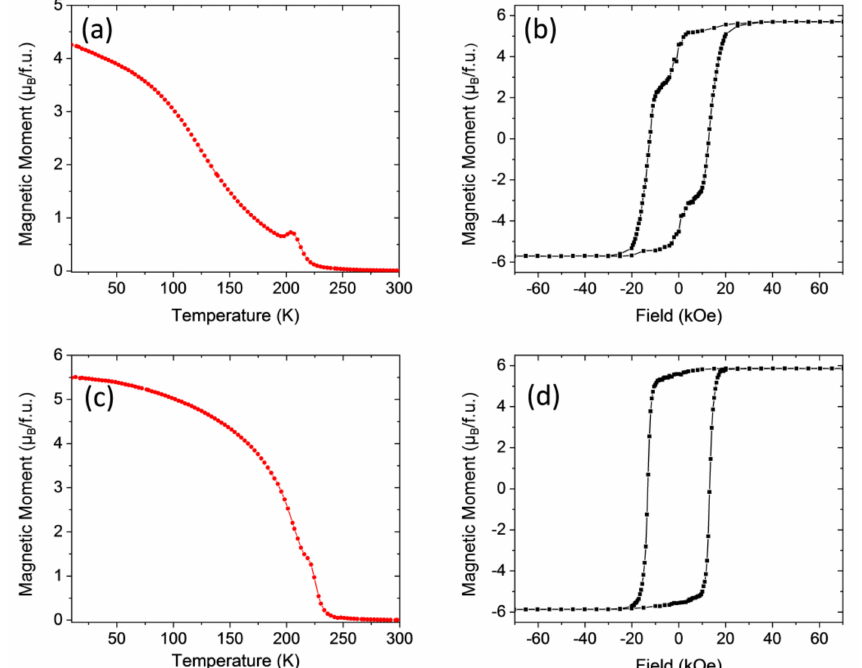
Figure 3. ( a ) Magnetization vs. temperature of LCMO / STO–1 film measured after field cooling with a magnetic field of 1 kOe applied parallel to (001)-STO (out of plane). ( b ) M–H loop of the same sample recorded at 10 K, magnetic field H applied out of plane. ( c ) Temperature dependence of the magnetization under an applied magnetic field of 1 kOe (out of plane), of sample LCMO / STO–1R. ( d ) M–H loop of sample LCMO / STO–1R recorded at 10 K, magnetic field H applied out of